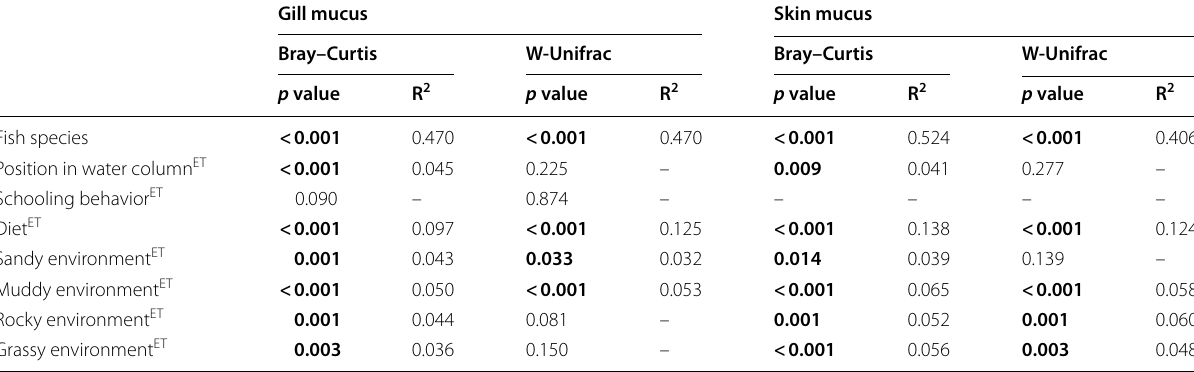
ET, ecological trait Significant p values are in bold (PERMANOVA, p <